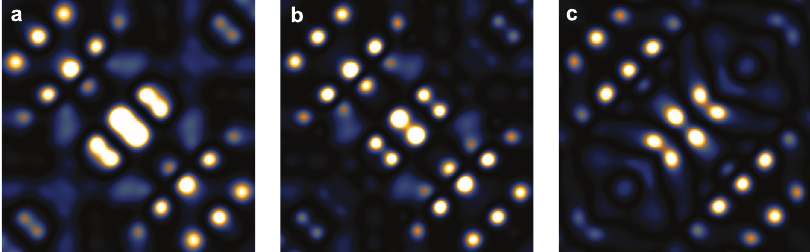
Fig. 3 Effect of various tip orbital combinations on STM images. All panels represent simulated STM images for a single P dopant at depth 4.75 a Si . Each image is computed with a different restricted linear combination of tip orbitals: a with s + p, b with s + d and c with p +